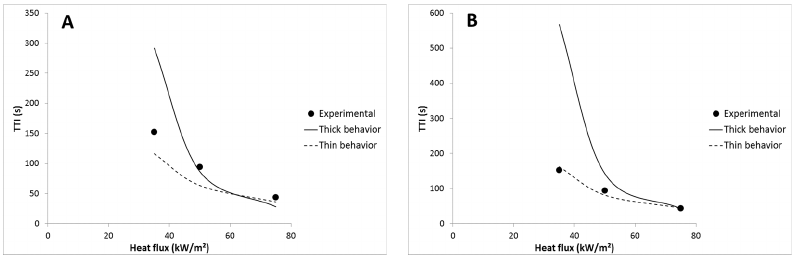
Figure 13. Experimental and predicted TTI versus heat flux for LDPE coated with 1A20-100 film: ( A ) emissivity = 0.76, ( B ) emissivity = 0.65.